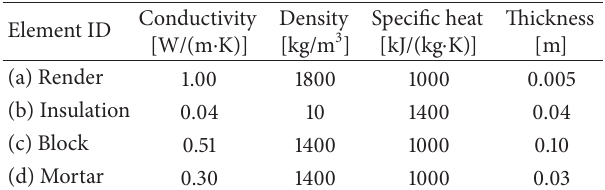
Table 4: Material properties.